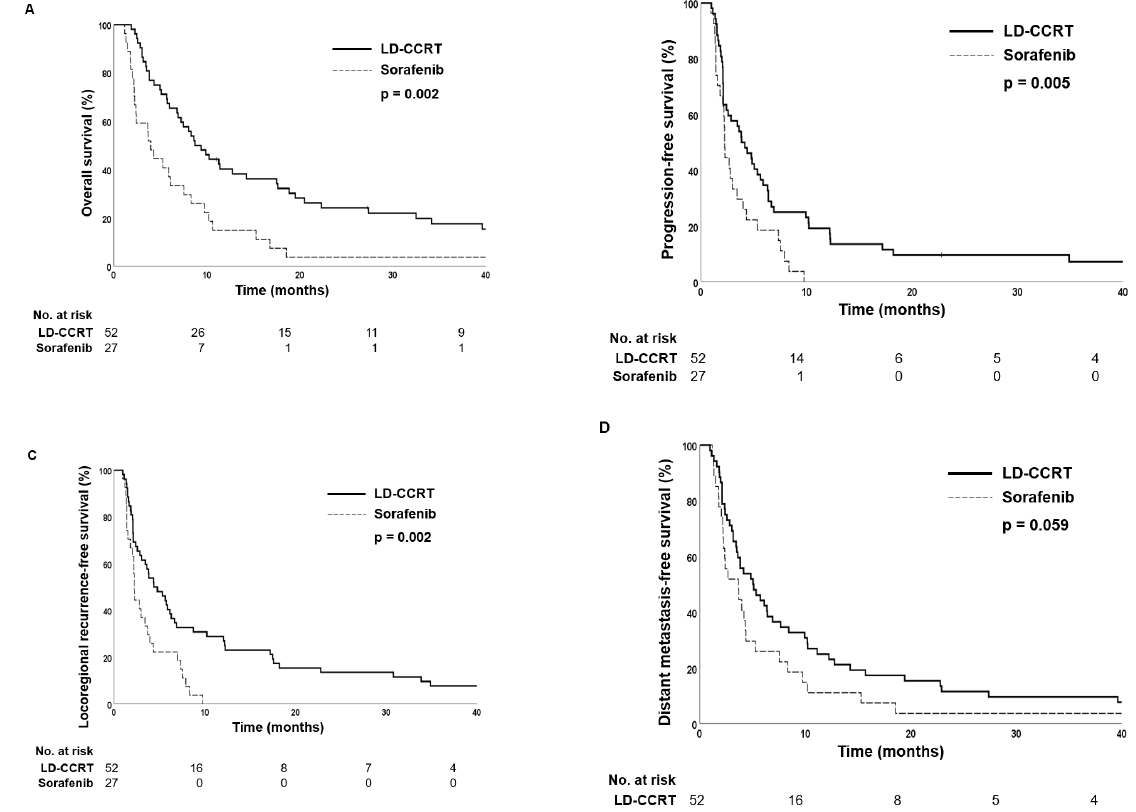
Figure 2. Kaplan–Meier estimates of ( A ) overall survival, ( B ) progression-free survival, ( C ) locoregional recurrence-free survival, and ( D ) distant metastasis-free survival in the propensity score-matched patients.